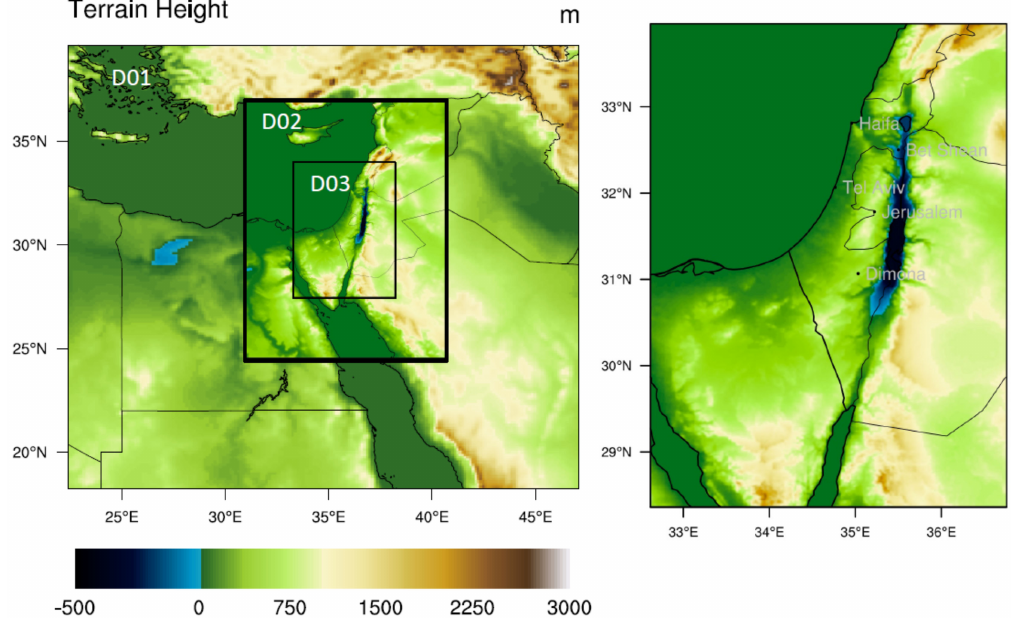
Figure 3. Topographical maps of the grid domains used in the simulation experiments (left). The outside grid, labeled D01, had 12 km grid spacing, while domain D02 (thick black border) had 4 km grid spacing. The innermost domain D03 (thin black border) had 1.3 km grid spacing. The Mediterranean and Red Seas are both colored dark green. Close-up of the highest resolution domain that shows the cities of Tel Aviv, Haifa, Bet Shean, Jerusalem, and Dimona (grey lettering). The Tzafit river gorge is located about 25 km southeast of